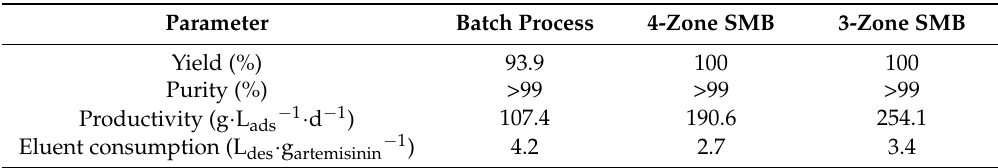
Table 6. Comparison of the process parameters for the batch process, the 3-zone SMB as well as the